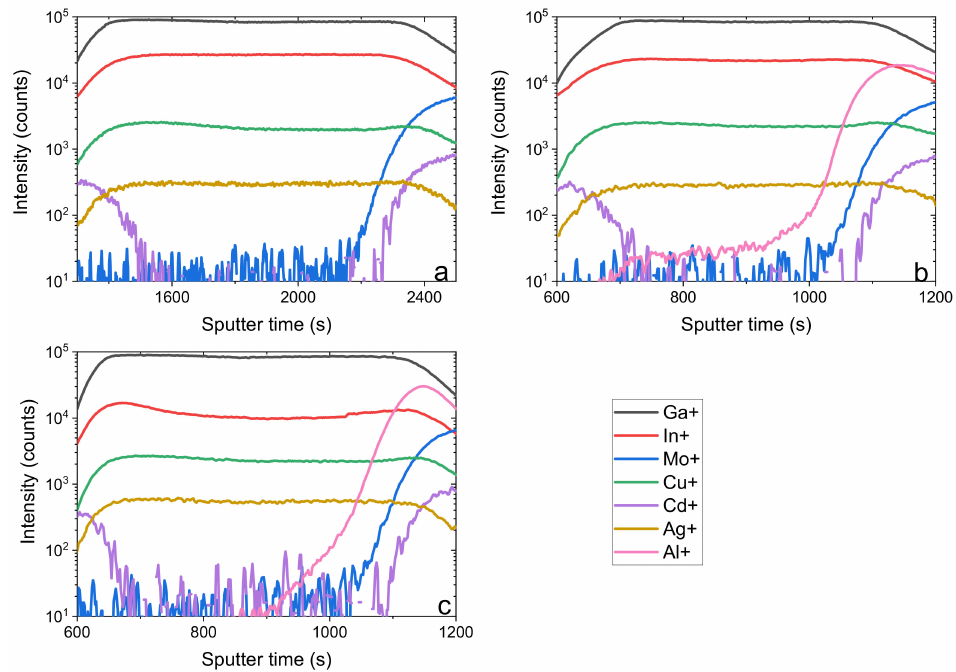
Figure A1. Elemental profiles of the 3 Ag-containing solar cells. ( a ) 10 nm Ag; ( b ) 10 nm Ag/3 nm AlO x ; and ( c ) 20 nm Ag/3 nm AlO x .